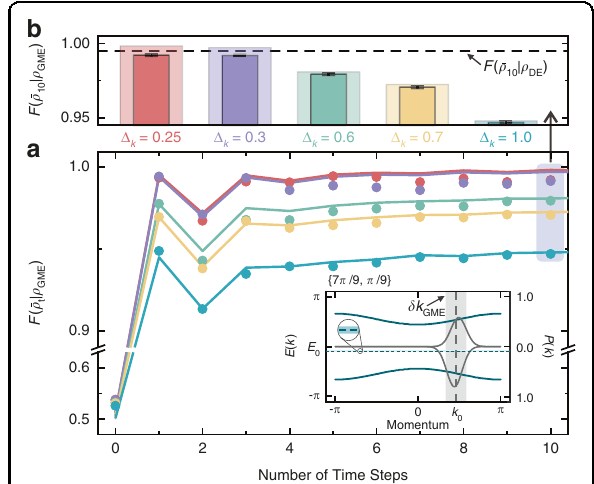
Fig. 5 Observing the generalized thermalization. a Fidelity (dots) and GME between the measured time-averaged coin states ρ t against the time steps, and b their values (opaque prediction ρ GME bars) after a ten-step walk. The initial Gaussian states have fi ve (cid:6) (cid:7) (cid:6) , and then evolve different widths Δ k but the same coin state # y governed by H eff ð 7 π = 9 ; π = 9 Þ . The colored solid lines in ( a ) and transparent bars in ( b ) represent the theoretical simulations. The inset in ( a ) shows the effective band structures (solid green lines with left- hand scale), the occupations of the two bands for one initial state with Δ : 3 as an example (gray curves with right-hand scale). The k ¼ 0 expected energy and momentum of the initial state is E 0 and k 0 , respectively. After expanding the initial state, the shift of the mean momentum of each band occupation relative to the k 0 takes the P following form: δ k Pð k ÞOð k (cid:2) k 0 Þ , where O denotes the order of the function. Moreover, the vertical gray and horizontal green regions depict the chosen momentum window with δ k GME ¼ 0 : 4 and associated energy window, respectively. The dashed line in ( b ) ρ indicates the lower bound (99.42%) of the measured Fð ρ 10 j DE